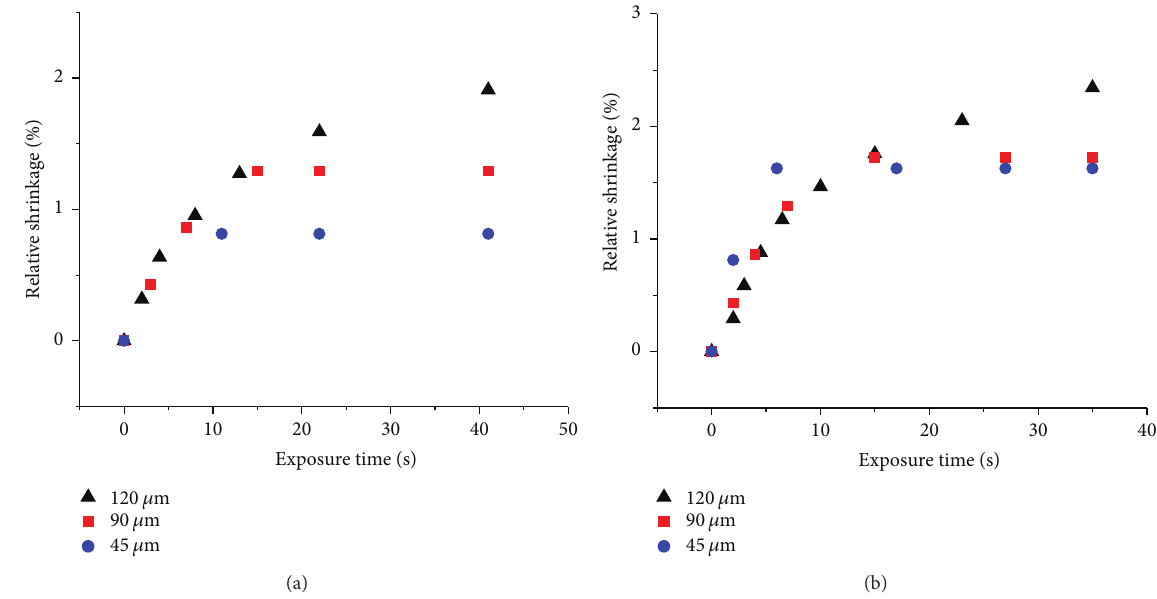
Figure 6: Relative shrinkage (%) versus exposure time (s) for gratings recorded in 45, 90, and 120 𝜇 m DA photopolymer layers using a recording intensity of (a) 5 mW/cm 2 and (b) 10mW/cm 2 .